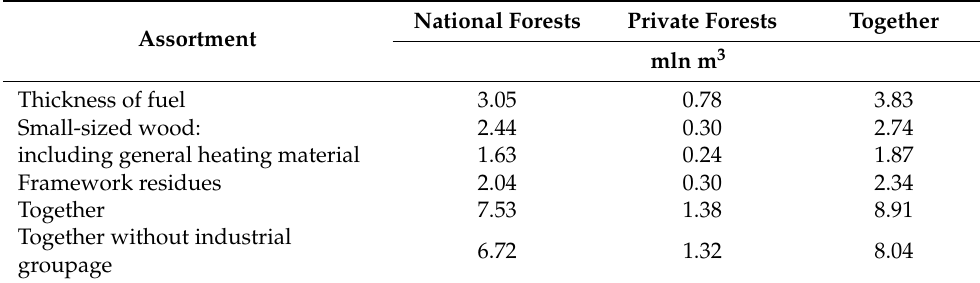
Table 3. Forecast of timber harvesting in 2031 for energy purposes in the State Forests and